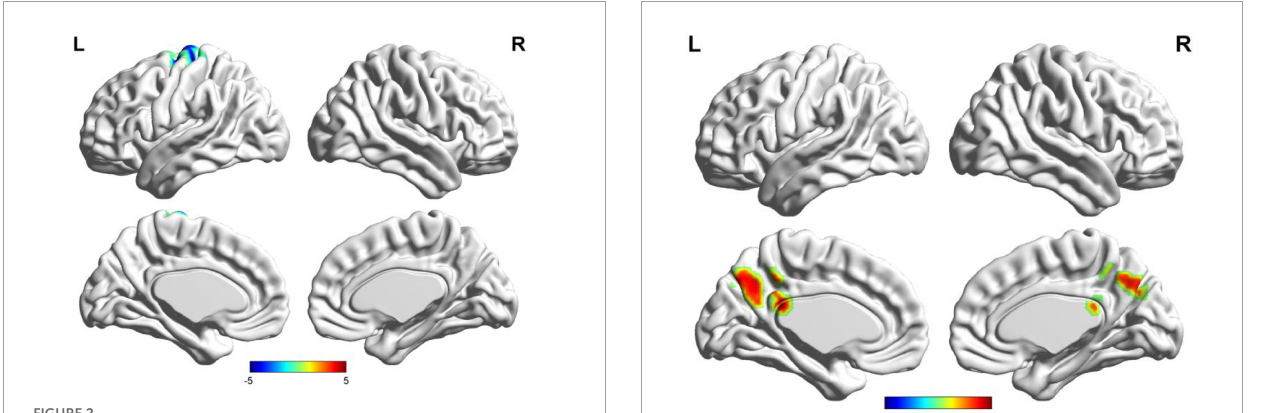
FIGURE2 Results of two-sample t -test of functional connectivity of Broca’s region (the seafarer group < the non-seafarer group; p 0.005, cluster size > 200 voxels, corresponding to corrected p FWE 0.05). R: right hemisphere, L: left hemisphere.